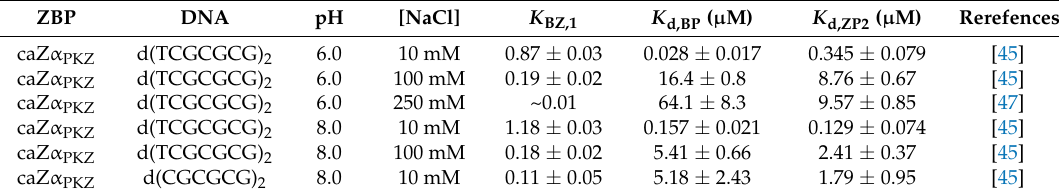
Table 2. Equilibrium constants for the caZ α PKZ -induced B-Z